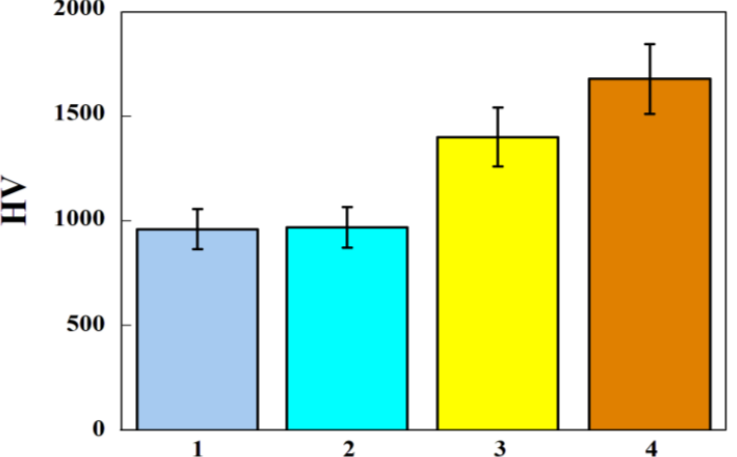
Figure 15. Influence of the alloy composition of the aluminum alloys (1 — AK12; 2 — AK9; 3 — AMg6; 4 — D16) on the microhardness of PEO layers synthesized in 3 g/L KOH + 2 g/L Na 2 SiO 3 electrolyte.: 1 — AK12; 2 — AK9; 3 — AMg6; 4 — D16.